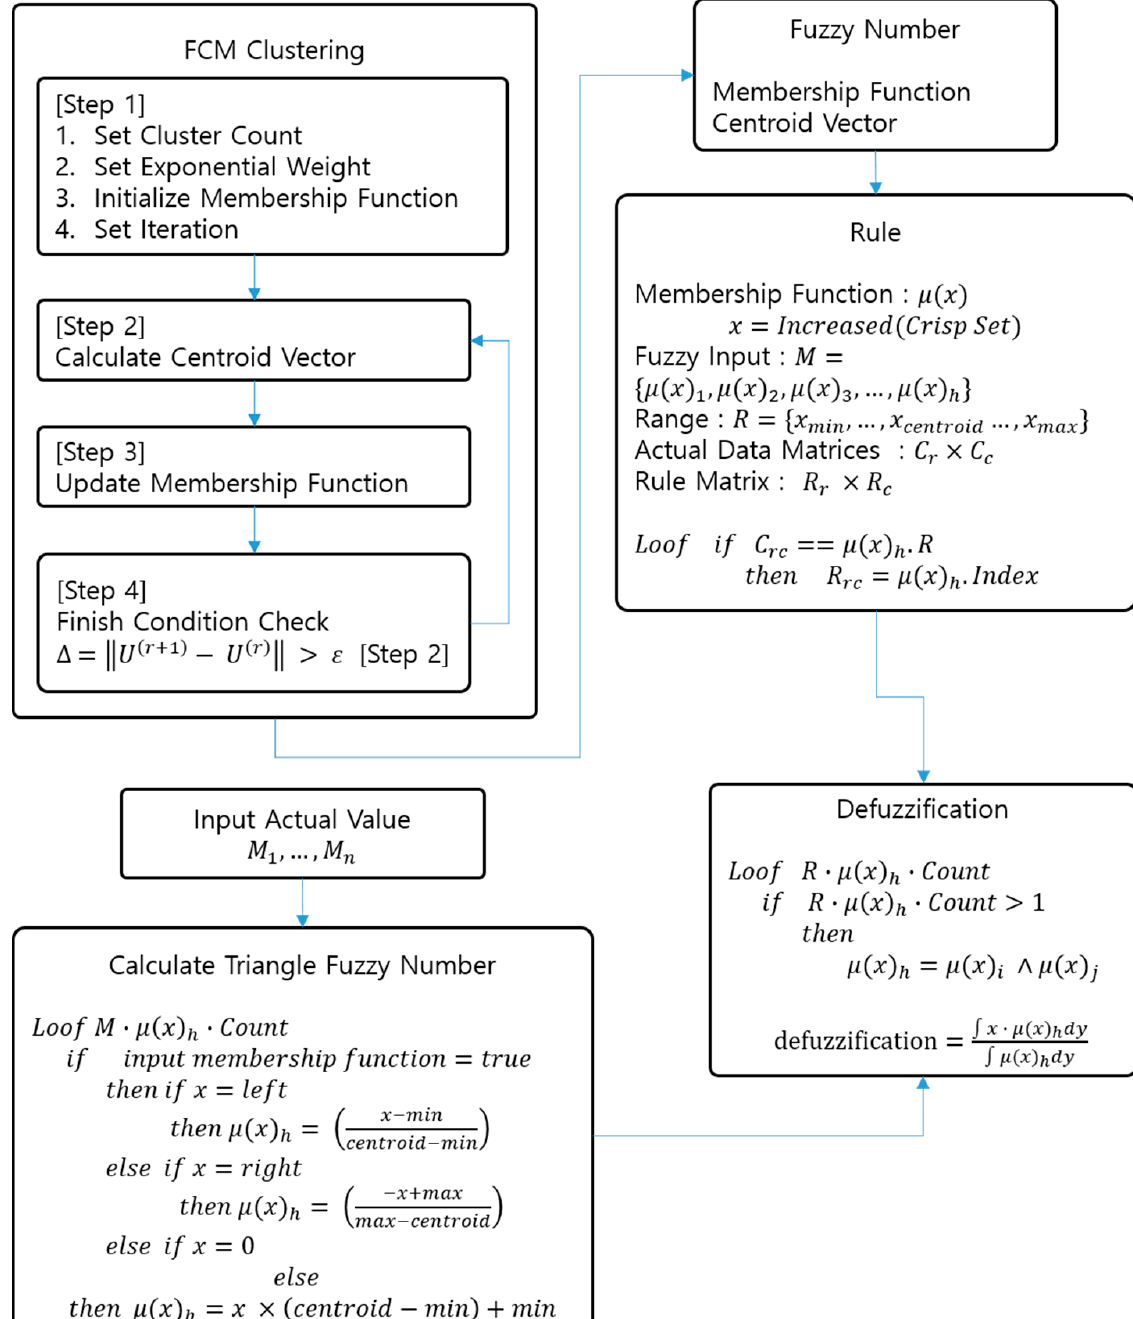
Figure 4. Algorithm of structured data analysis.